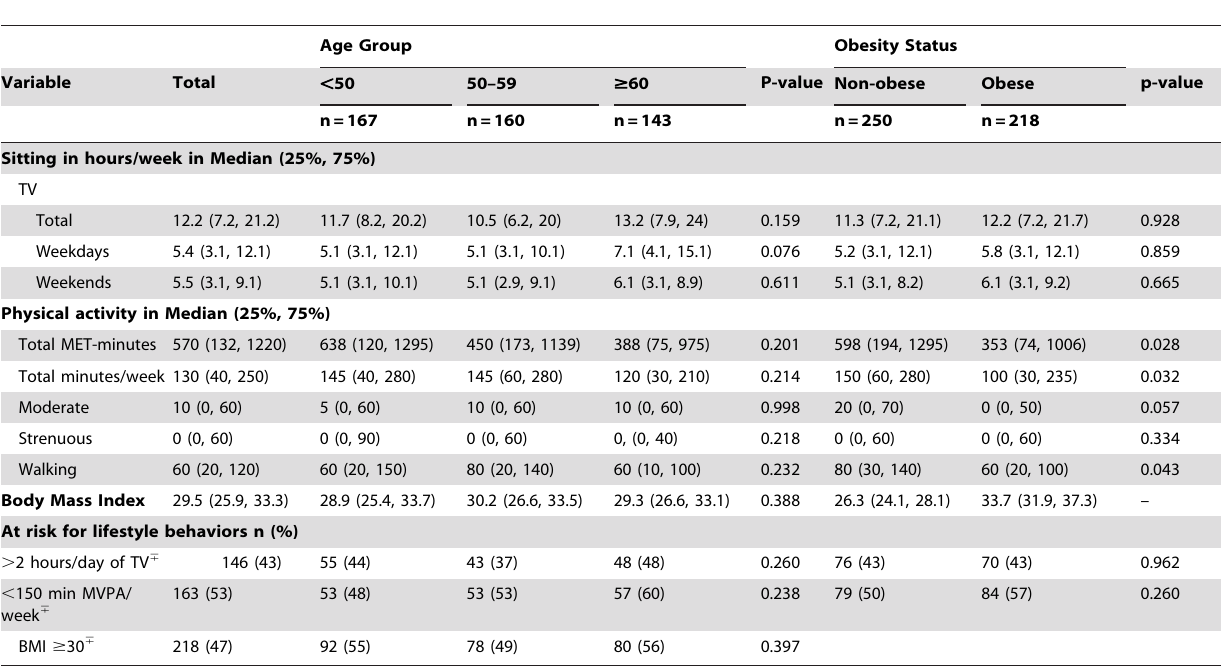
Table 2. Physical activity and sedentary habits of AA breast cancer survivors.